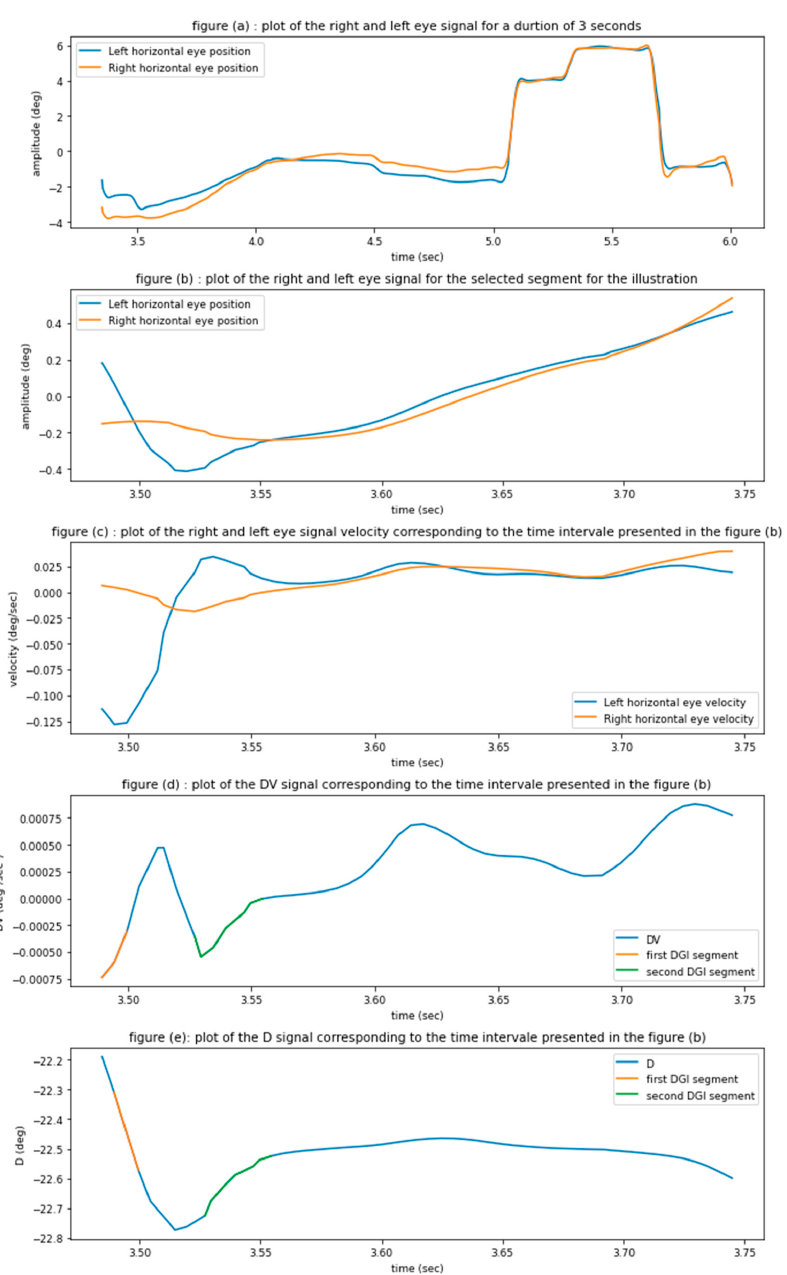
Figure 1. Illustration of the selected segment by our algorithm and the different steps used by the DGI algorithm. Subfigure ( a ) present the time series position of the left eye on the horizontal axis over time and the position of the right eye on the horizontal axis over time. Subfigure ( b ) present a partition of the two signals presented on Subfigure ( a ). Subfigure ( c ) present the first derivative of the two signal presented in subfigure ( b ). Subfigure ( d ) present the DV signal, defined as the product of the first derivatives of the left signal and the right signals. Subfigure ( e ) present the D signal, defined as the difference of the left horizontal signal and the right horizontal signal, and enumerate the DGI segments present on the D